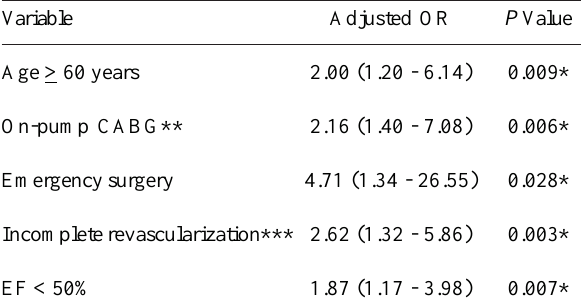
Table 3. Multivariate analysis by logistic regression